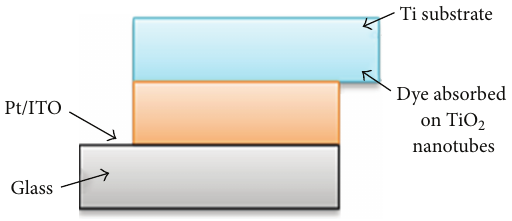
Figure 1: Structure of the fabricated